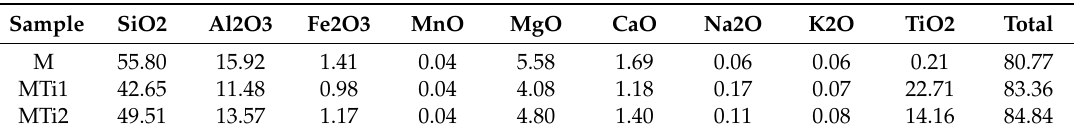
Table 1. Chemical composition of the starting natural clay and of the synthesized solids, expressed as a percentage of oxides for each element (wt %).